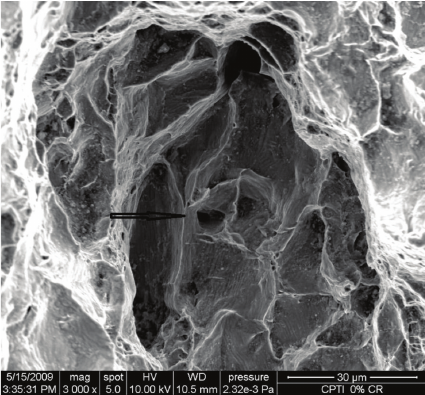
Figure 7: Scanning electron micrograph shows intergranular frac- ture of implant (large dimple at the center of implant surface is shown by